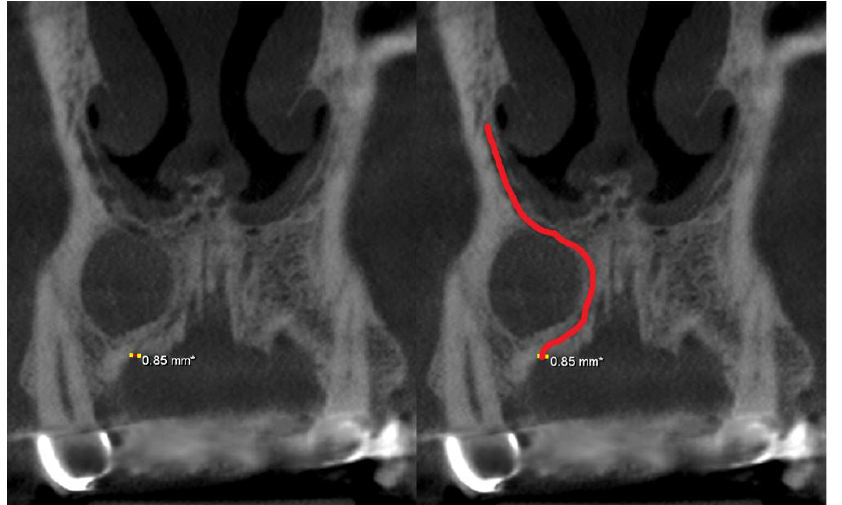
Figure 1. Coronal CBCT slices of an excluded case of an AC ( red line ) which was displaced due to a radicular cyst. Note that this accessory canal with a 0.85 mm diameter, ends at the crest of the alveolar ridge.